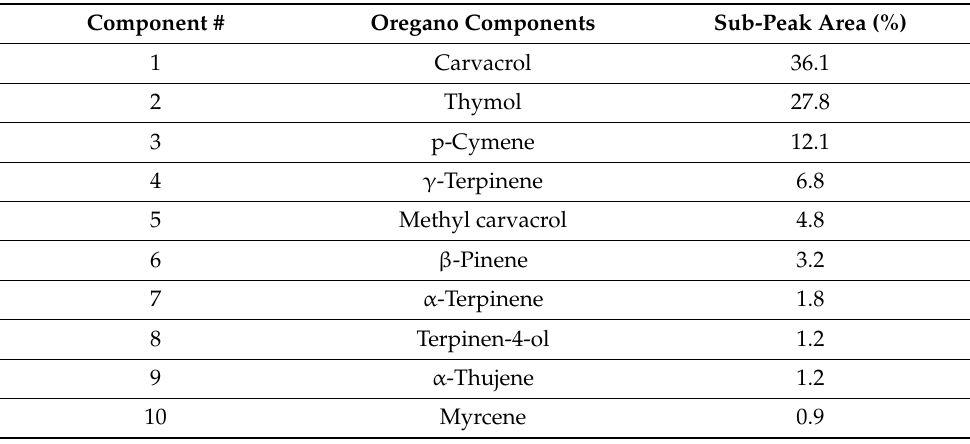
Table 1. Oregano